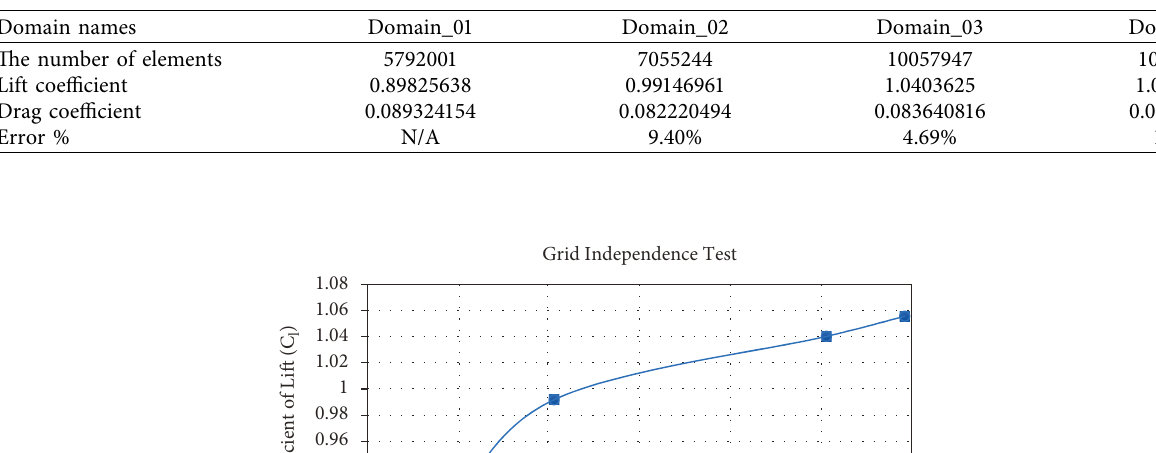
Table 2: Grid independence test.